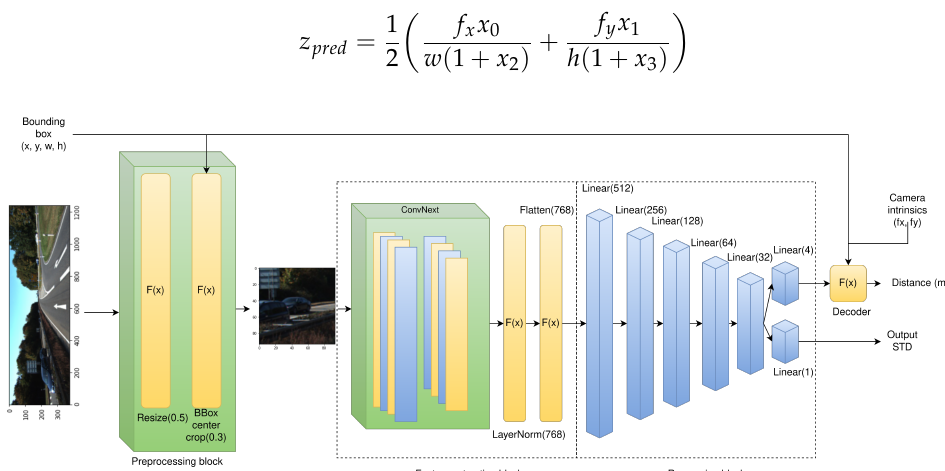
Figure 2. The CDR model topology. The model was trained with a batch size of 512, learning rate of 0.0005 and the Adam optimizer. The version of the network presented in the picture corresponds to the “base” decoder function, using the top output fully-connected layer with four neurons. The model was implemented in